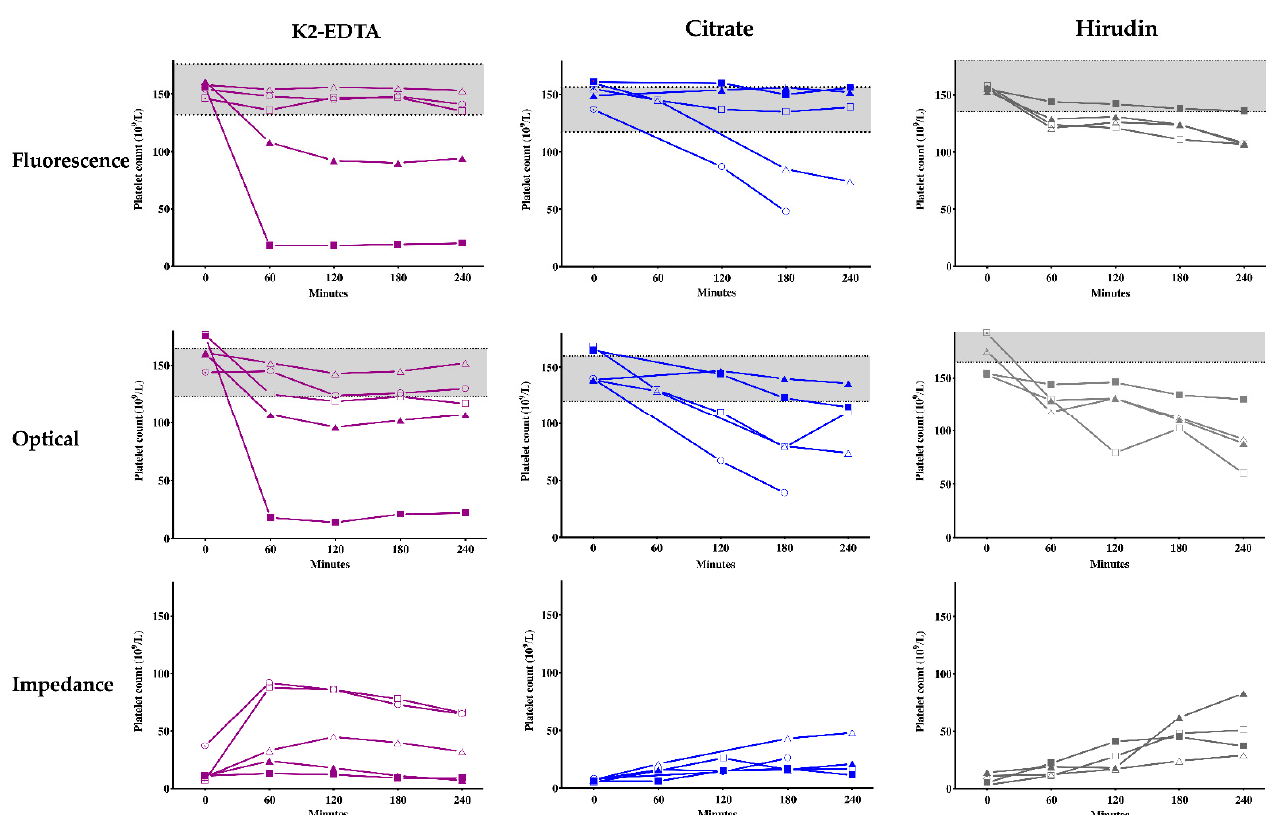
Figure 3. Changes of platelet counts over time according to different anticoagulants (K 2 -EDTA, Na-citrate, hirudin), meas- urement methods and conditions (control, amikacin or not, room temperature or 37 °C). The grey zone corresponds to the RCV based on the control tube at baseline for K2-EDTA, sodium citrate and on amikacin-free tube at room temperature for hirudin. Control hirudin tube was excluded since a blood clot was found. Control, RT, Amikacin, RT, Amikacin, 37°C, No amikacin, RT, No amikacin, 37 °C.